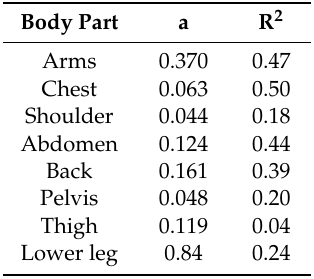
Table 4. Linear regression equations of local f cl and I cl for di ff erent body